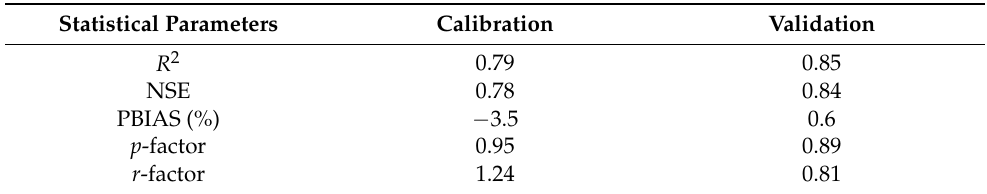
Figure 13. Model performance during the validation stage. Table 8. Statistical evaluation of the calibration and validation of the SWAT model on the KRB at a monthly time